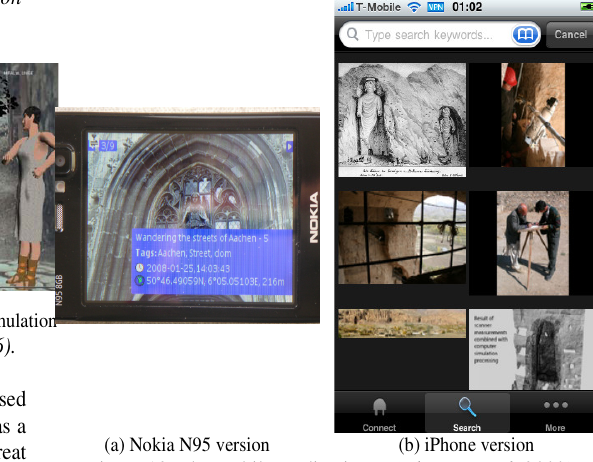
Figure 10. The mobile media viewer (Klamma et al,